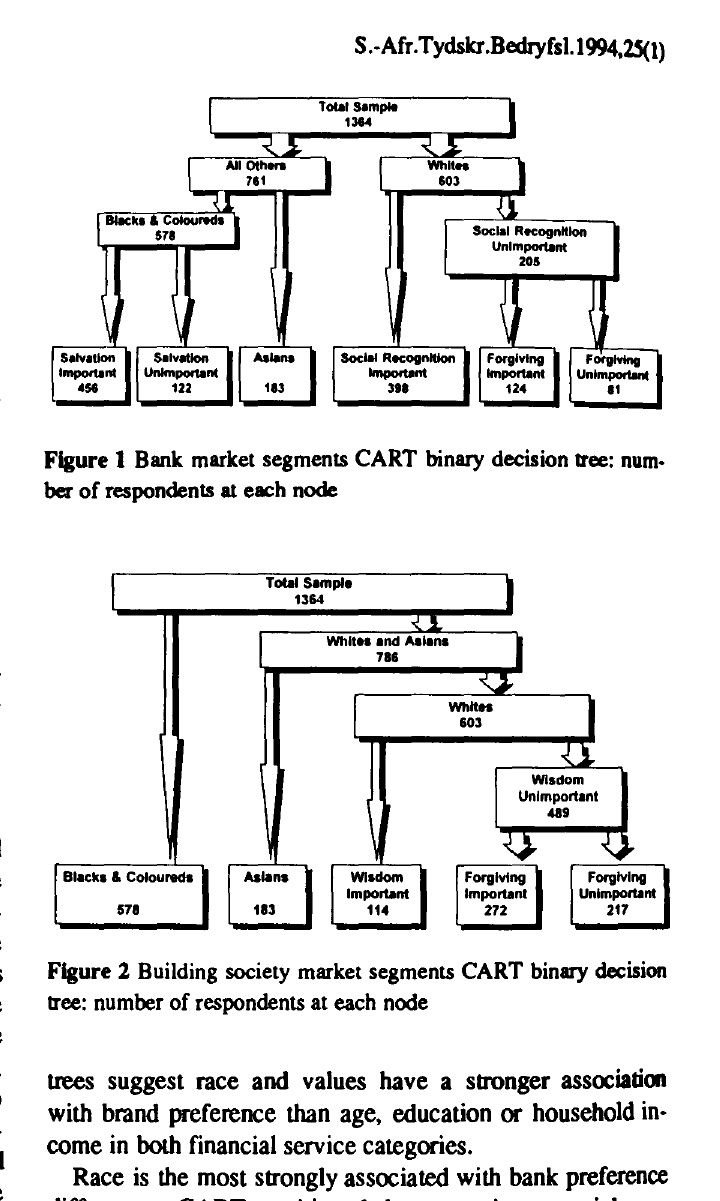
trees suggest race and values have a stronger association with brand preference than age, education or household in come in both financial service